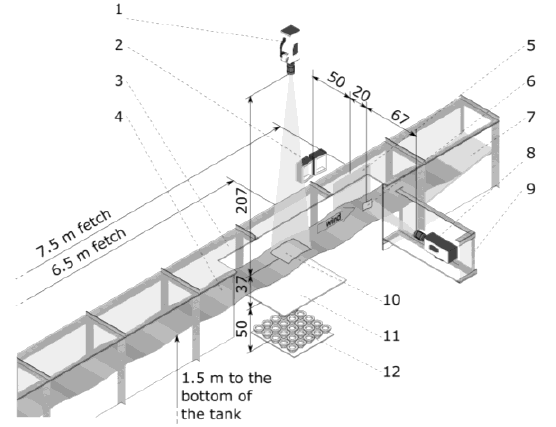
Fig. 1. General scheme of experiment including 1) camera NX-